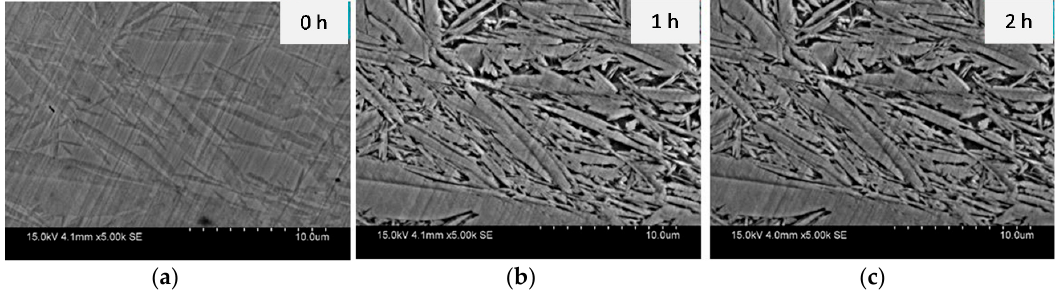
Figure 1. Effect of corrosion on each phase: ( a ) after etching or t = 0 h, 0.5 M NaCl media after, ( b ) t = 1 h and ( c ) t = 2 h. the black area is the retained austenite and grey area is martensite. The evidence of corrosion and amount of retained austenite degradation due to the preferential attack on the retained austenite was detected using weight-loss